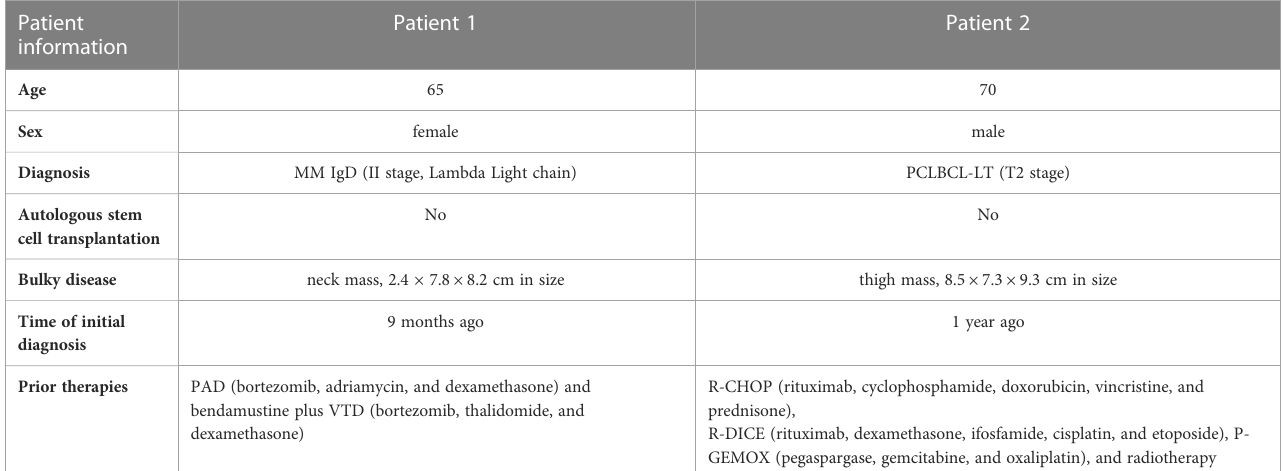
TABLE 1 The general clinical characteristics of the patients.